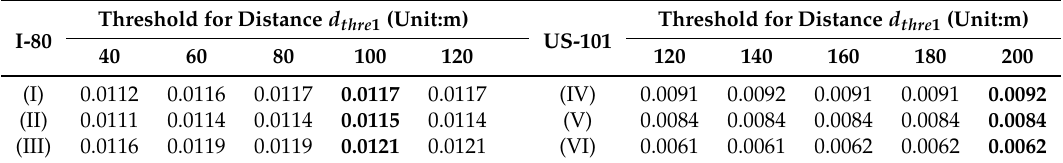
Table 4. Parameter comparison for distance d thre 1 .